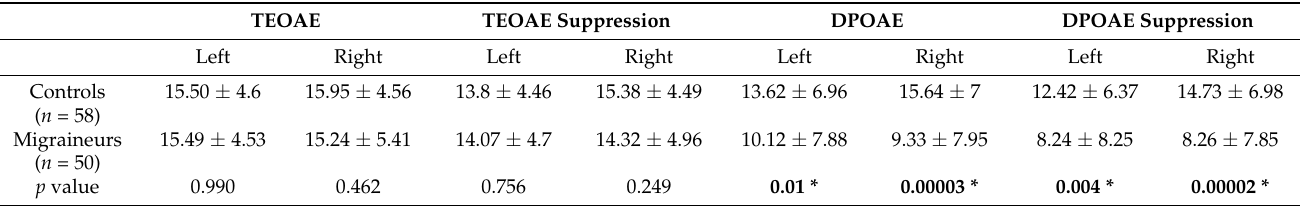
Table 2 . OAE testing results in controls and migraineurs. Table 2. OAE testing results in controls and migraineurs.